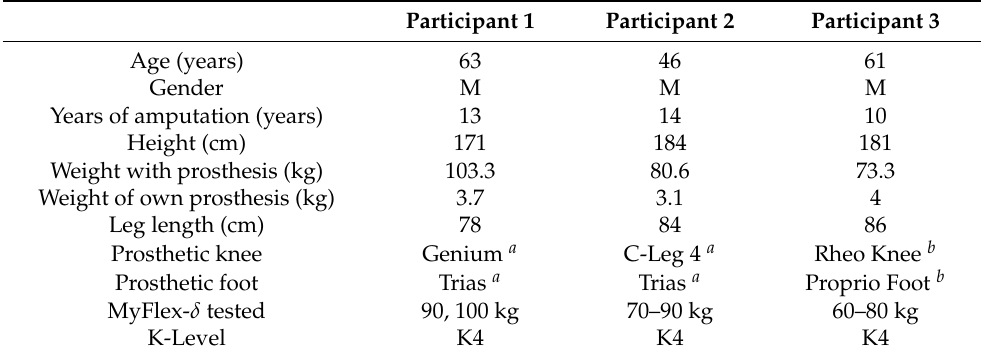
Table 2. Characteristics of the participants included in the MyFlex- δ functional tests. a = Ottobock, b =